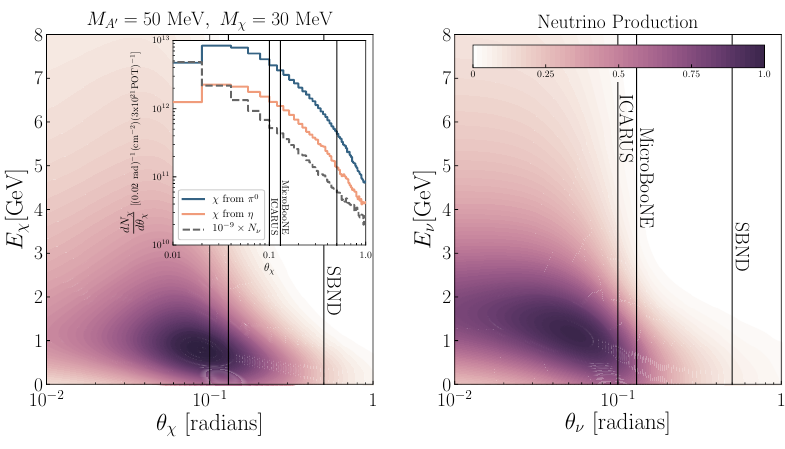
Figure 4 . The di(cid:11)erential distribution of (cid:31) particle (left) and neutrino (right) production as a function of the particle energy and production angle in arbitrary units. The model parameters used here are " = 10 (cid:0) 3 , M (cid:31) = 30 MeV and M A 0 = 50 MeV. In the insert we show the energy-integrated (cid:31) particle (cid:13)ux as a function of the production angle, 684 meters away from the NuMI target, due to (cid:25) 0 (blue) and (cid:17) (orange) decays as well as the o(cid:11)-axis angular distribution of the neutrino (cid:13)ux (gray). The neutrino (cid:13)ux has been rescaled by 10 (cid:0) 9 . A larger fraction of (cid:31) ’s are produced o(cid:11)-axis as compared to